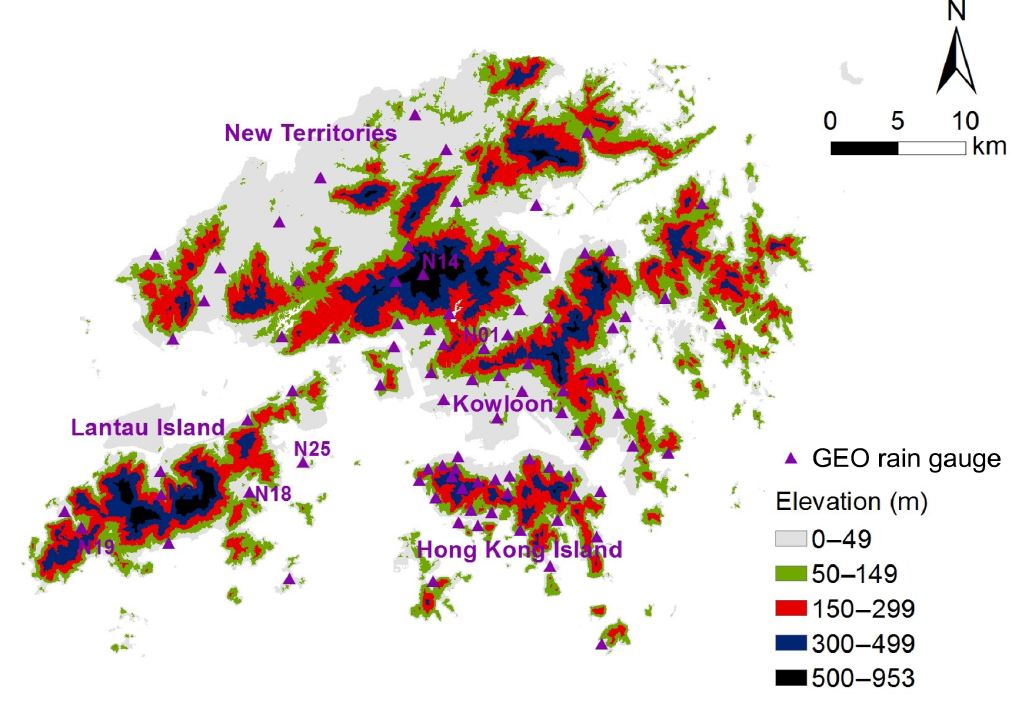
Figure 3. The GEO rain-gauge network in Hong Kong.